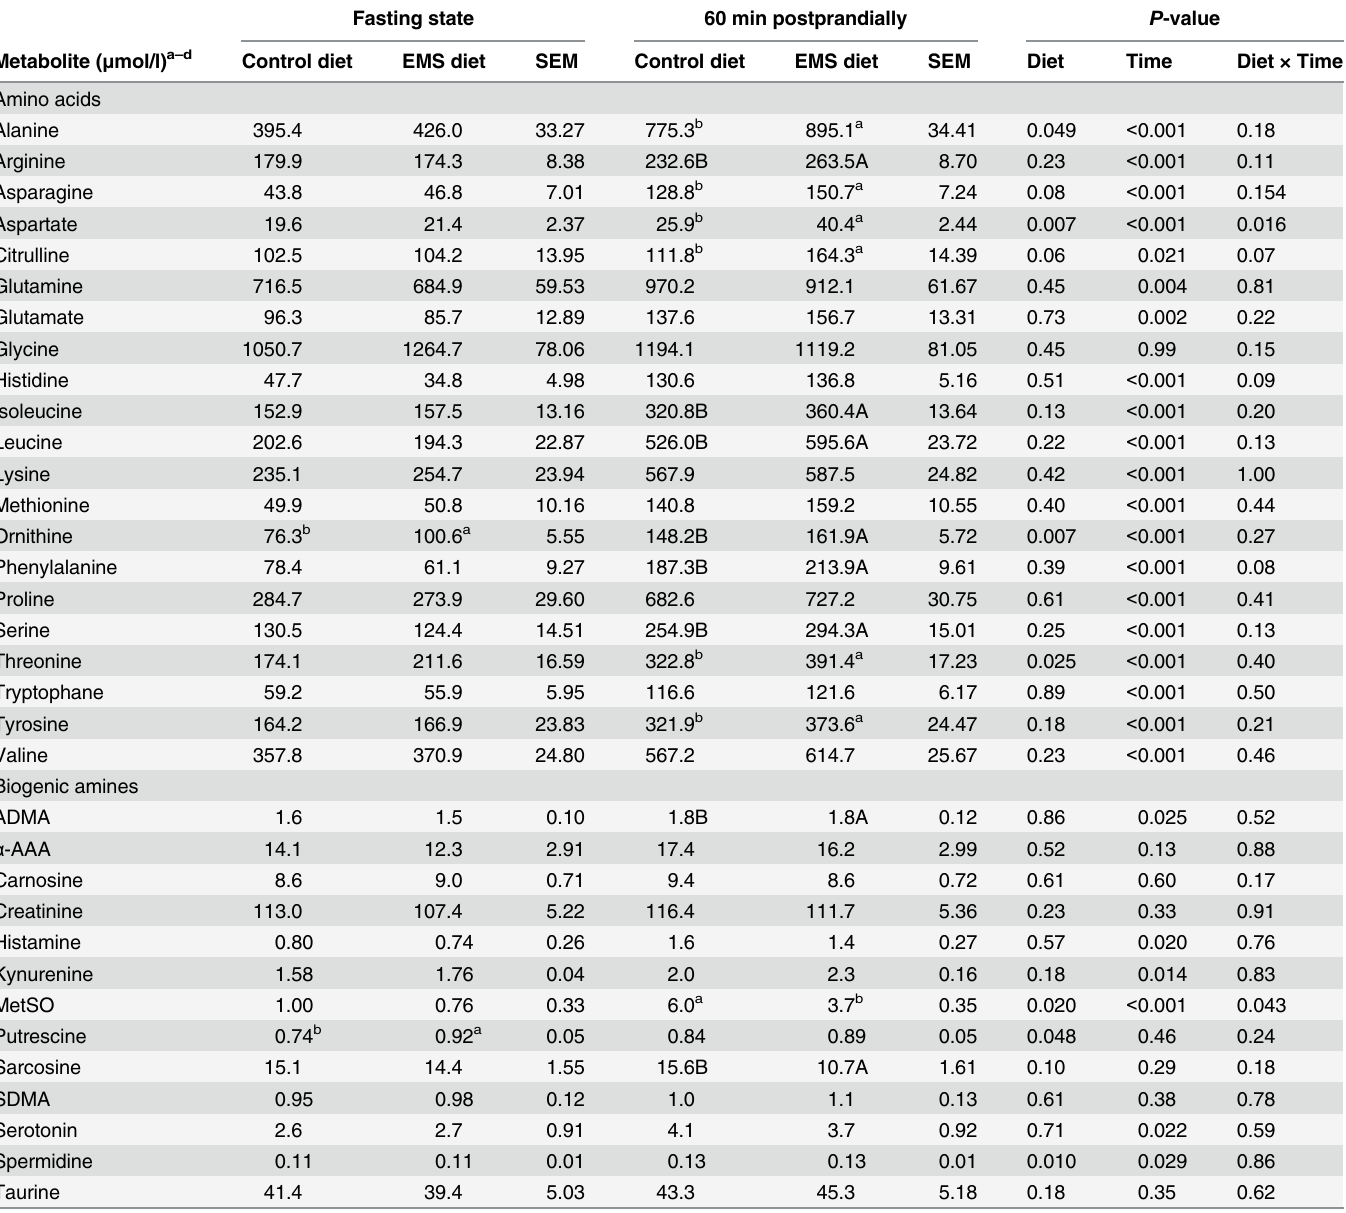
Table 4. Serum amino acids and biogenic amines ( μ mol/l) of pigs fed the enzymatically modified starch (EMS) diet or control diet in the fasting state and at 60 min postprandially. Fasting state 60 min postprandially P